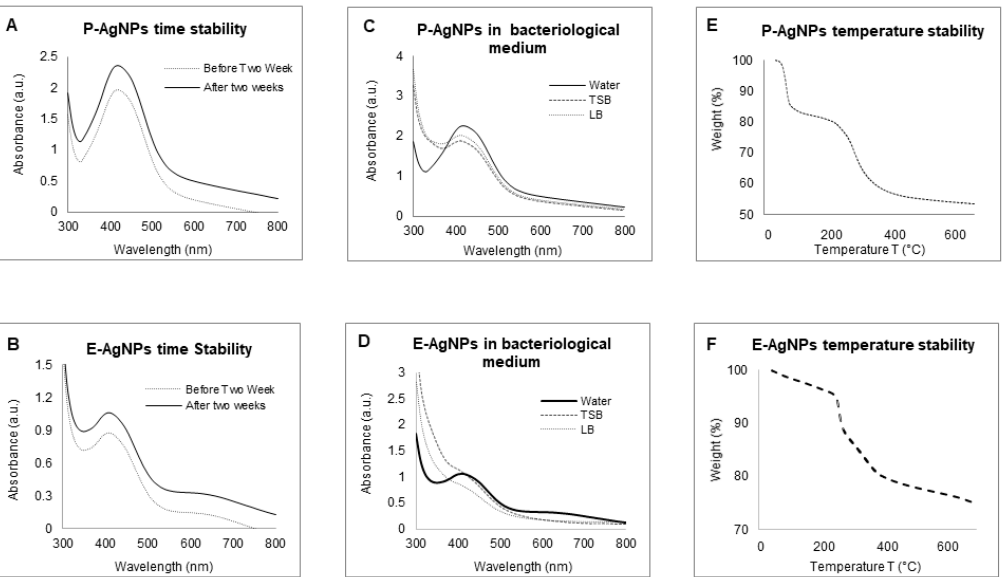
Figure 8. UV-Vis spectrum representing the stability analysis, before and after two weeks of incu- bation at RT for ( A ) P-AgNPs, and ( B ) E-AgNPs; in a different medium, ( C ) P-AgNPs, ( D ) E-AgNPs; at the temperature range from 20–700 °C measured by TGA instrument, ( E ) E-AgNPs, ( F )